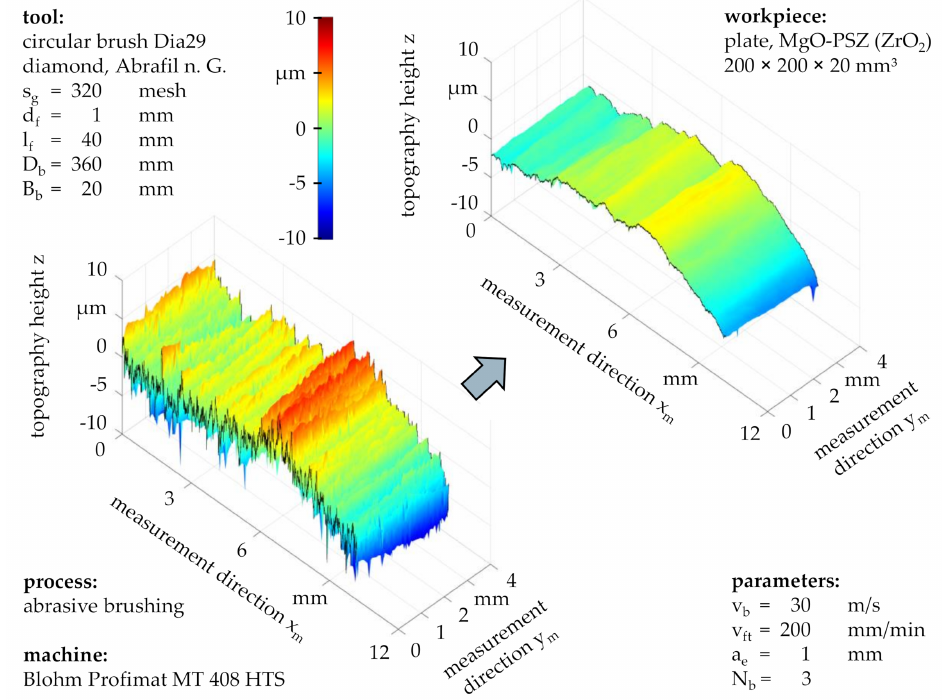
Figure 11. Topography of ZrO 2 , brushed with a brushing velocity of v b = 30 m /